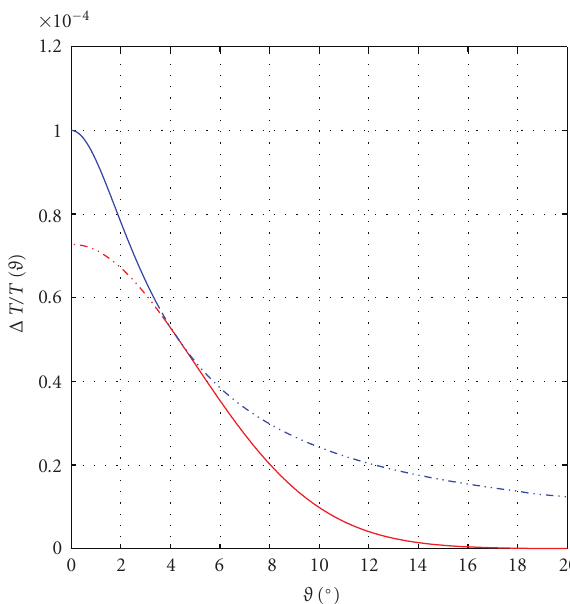
Figure 12: Radial profile (solid blue/red lines) of a cosmic texture, as given in (14). The parameters defining this profile are ε = 10 − 4 and ϑ c = 5 ◦ . The dashed lines represent the truncated values of the profiles given by (13) (blue) and the Gaussian function (red). See text for